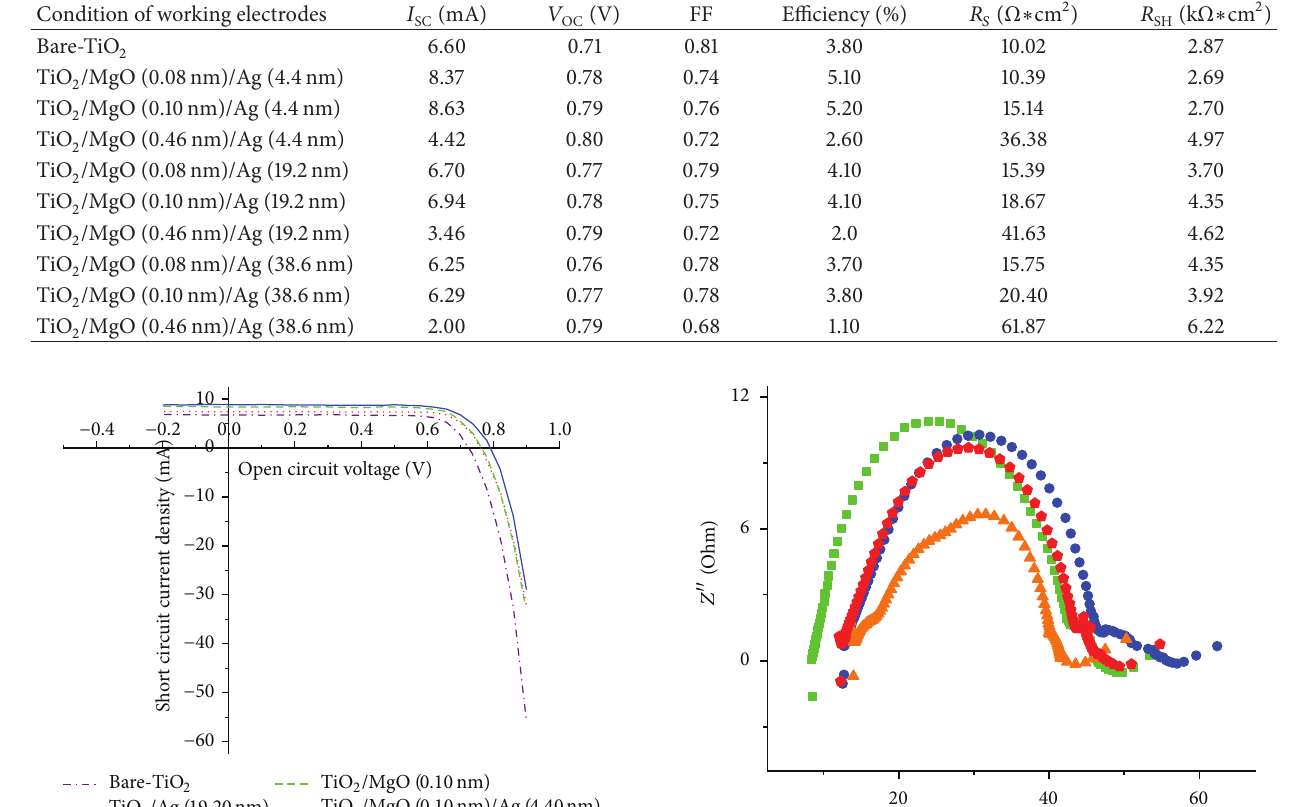
Table 2: The short circuit current densities ( 𝐼 ), open circuit voltages ( 𝑉 ), fill factors (FF), efficiencies, series resistances ( 𝑅 𝑆 ), and shunt SC OC )ofDSSCspreparedusingtheTiO 2 /MgO/Agcompositefilmelectrodescomparedwithbare-TiO 2 electrode(reference)under resistances( 𝑅 SH